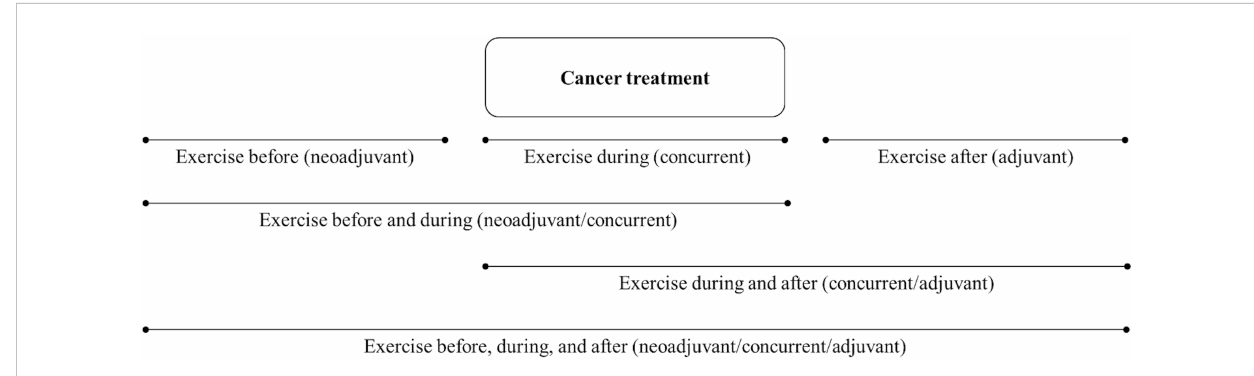
FIGURE 3 Diagram of possible sequencing of exercise treatment in relation to a single nonsurgical cancer treatment that could be analyzed in observational